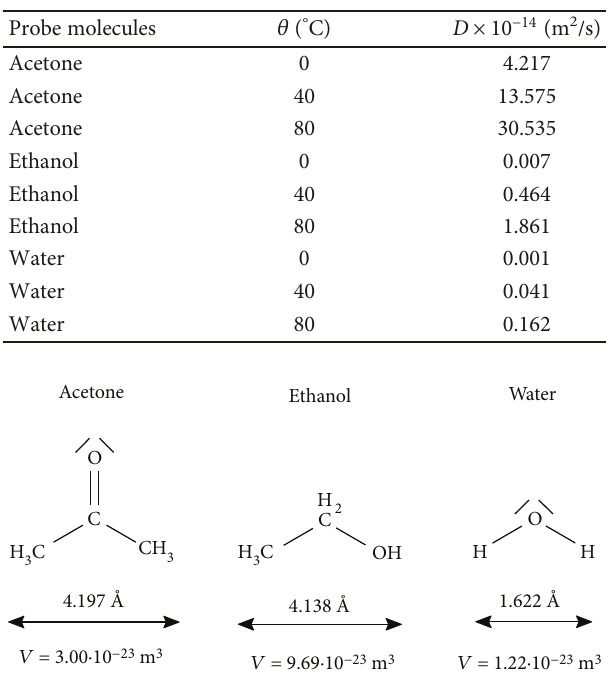
Figure 5: Structure formula and size of acetone, ethanol, and water, considering a spherical model [33]. The volume of the solvents and their radiuses are calculated from their densities at θ = 20 ° C [34,